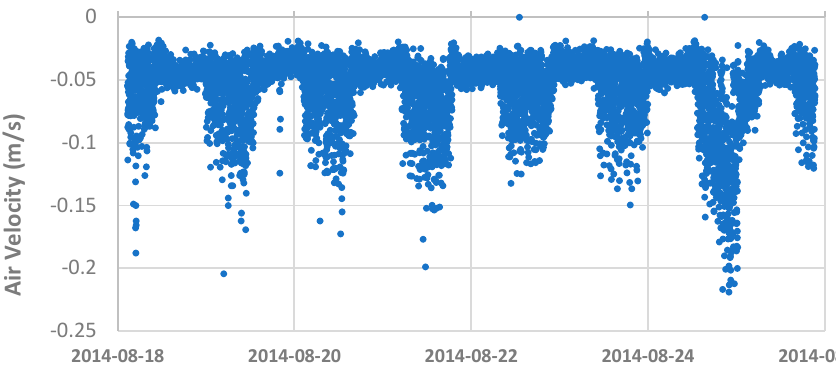
Figure 2. Recorded indoor air velocities in the living room at a 1.2 m height above the floor: one recording per minute.